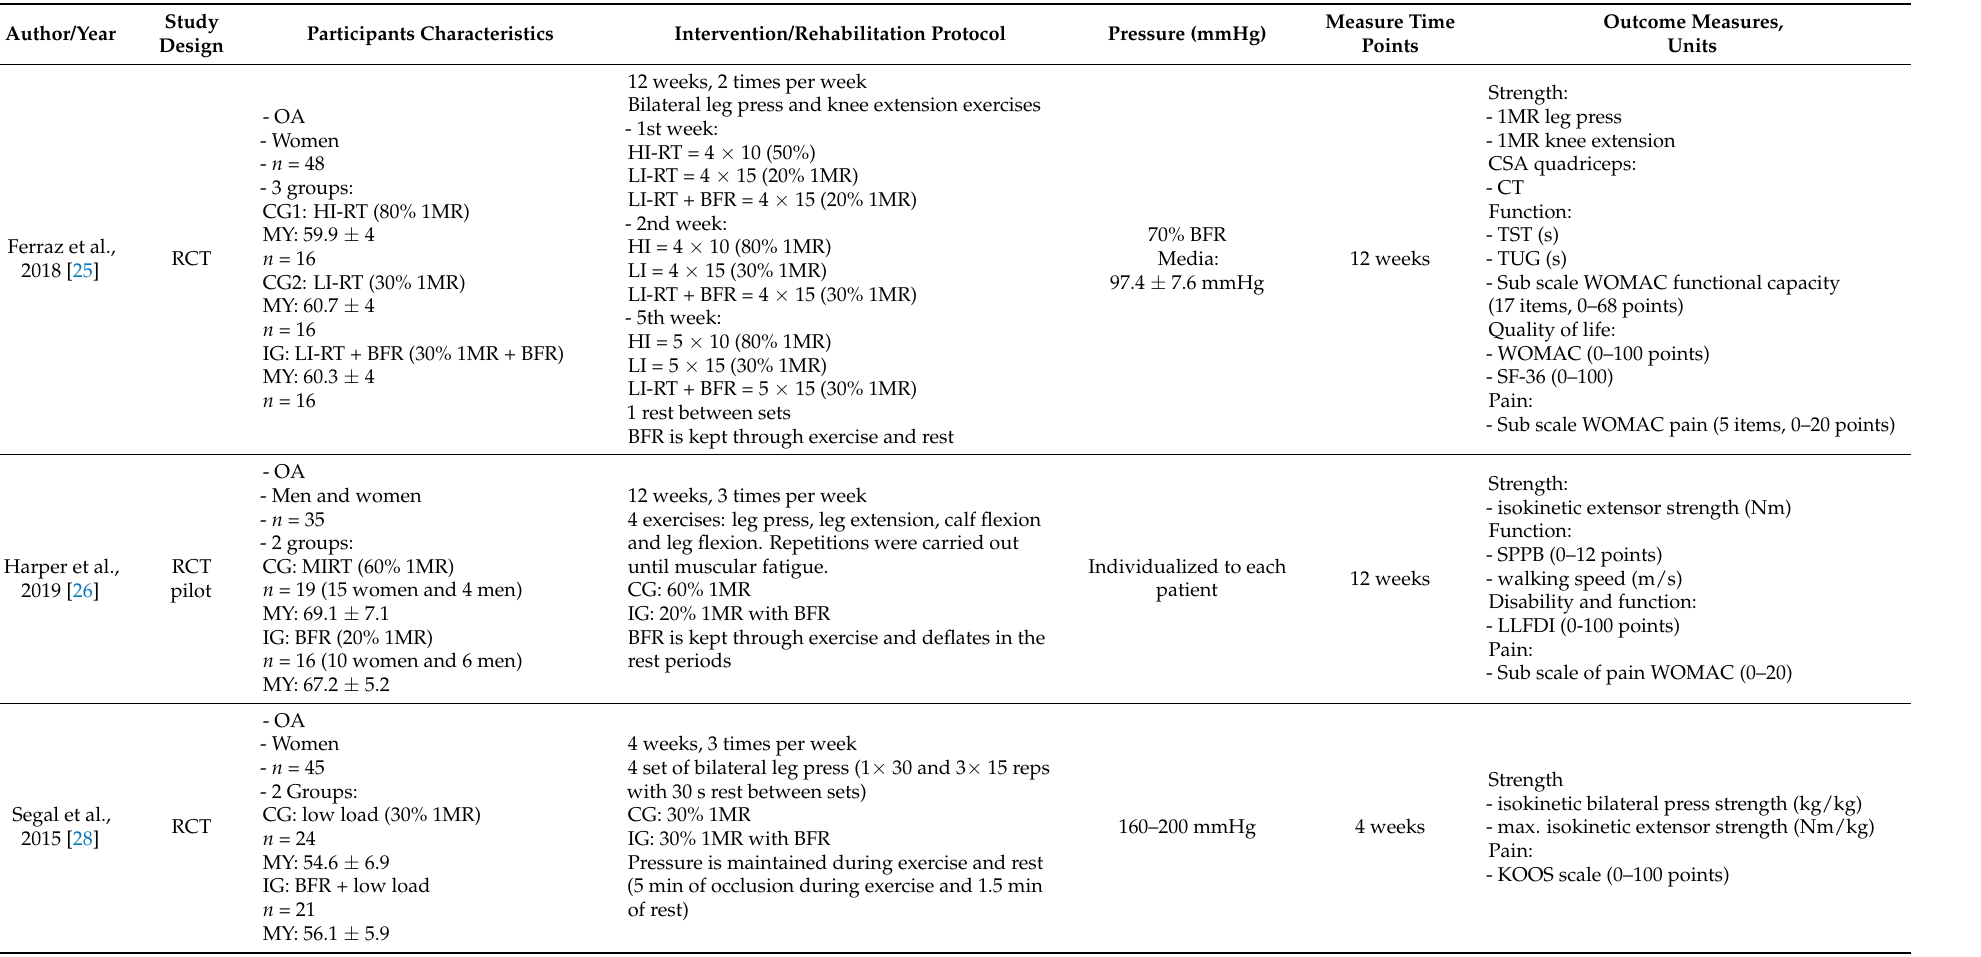
Table 1. Characteristics of the studies included in the